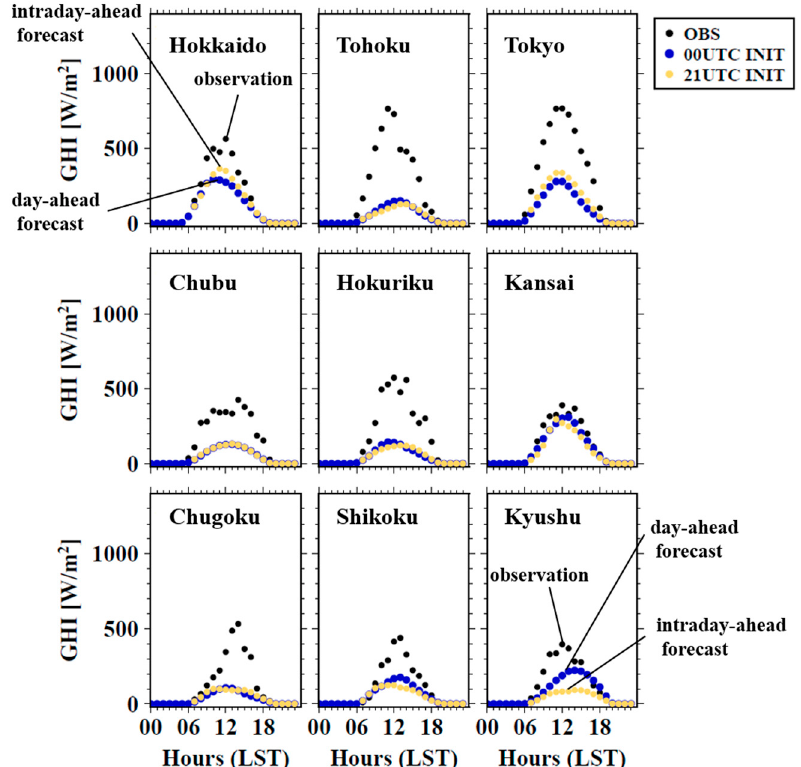
initialization time of 09 UTC, ( d ) 12-h forecasts with initialization time of 15 UTC and ( e ) 6-h forecasts with initialization time of 21 UTC.